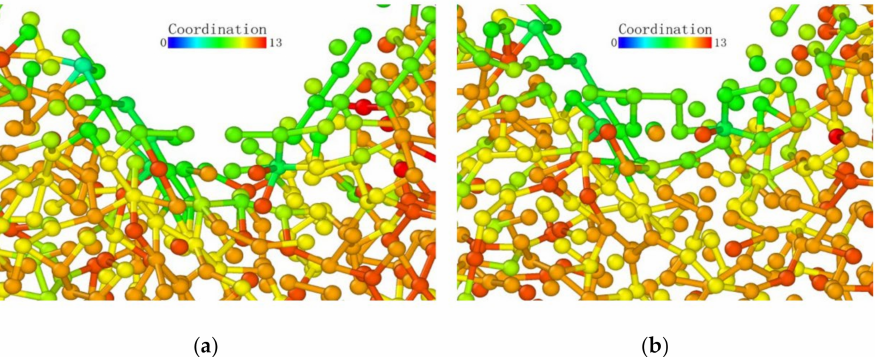
Figure 14. The coordination number at the end of loading (380 ps) and the coordination number at the rebound pole (385.2 ps). ( a ) 380 ps ( b ) 385.2